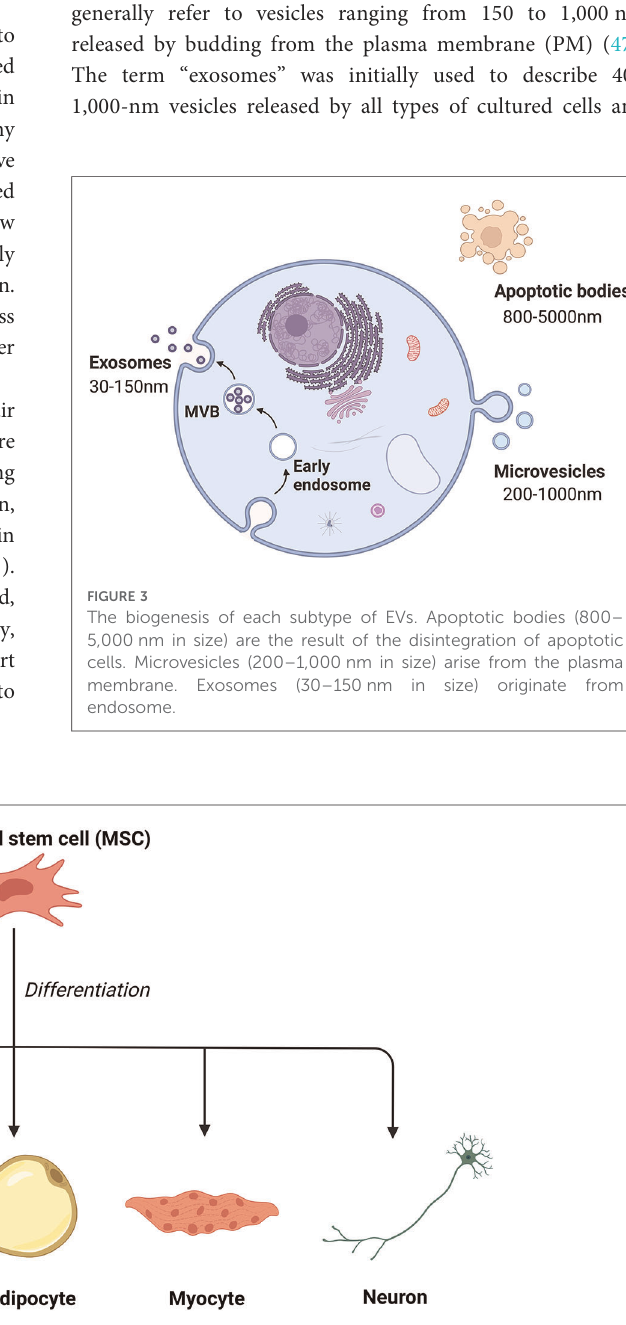
FIGURE 2 The differentiation of mesenchymal stem cells. Mesenchymal stem cells can differentiate into various mesenchymal tissue lineages, such as osteoblasts, chondrocytes, adipocytes, myoblasts, and even neurons.